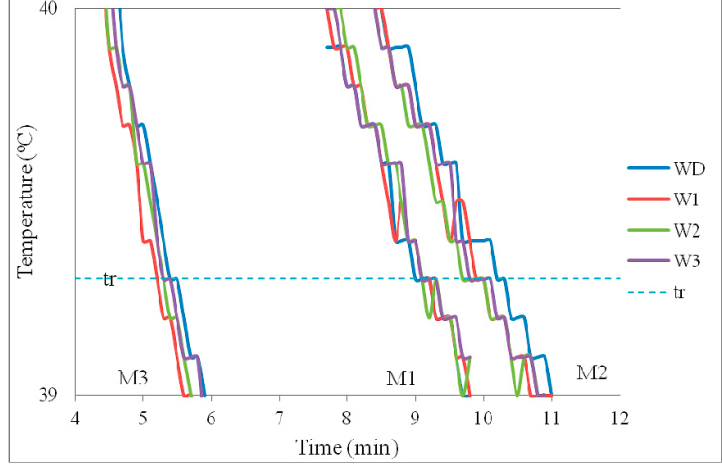
Minerals 2019 , 9 , x FOR PEER REVIEW Figure 6. The cooling curves for the mixtures of the three clays and four waters. t r = relaxation time.